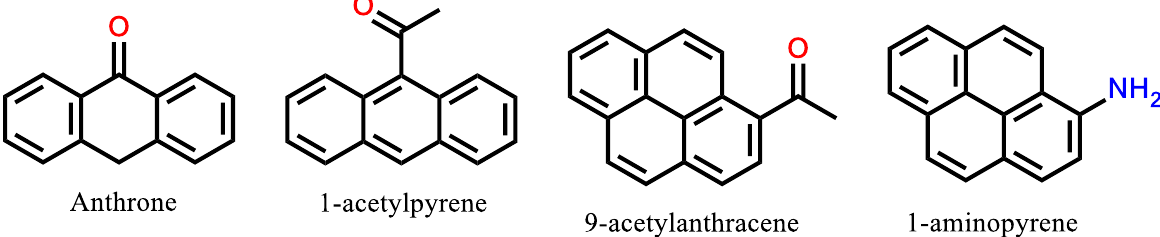
Figure 13. Examples of aromatic molecules that eluted to the Aro-3 fraction that would have otherwise eluted in the Aro-2 fraction if the heteroatoms were replaced by hydrogen atoms. (The red color indicates oxygen atom, and the blue color—the NH 2 group.)